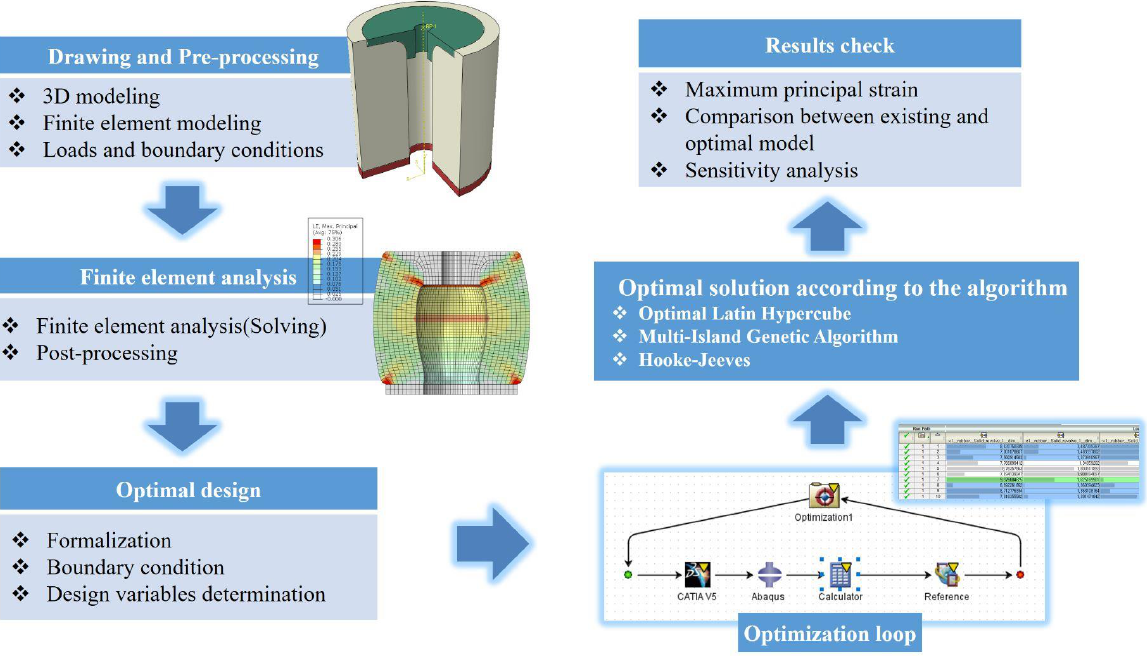
Figure 12. Flowchart of the iterative optimization procedure.